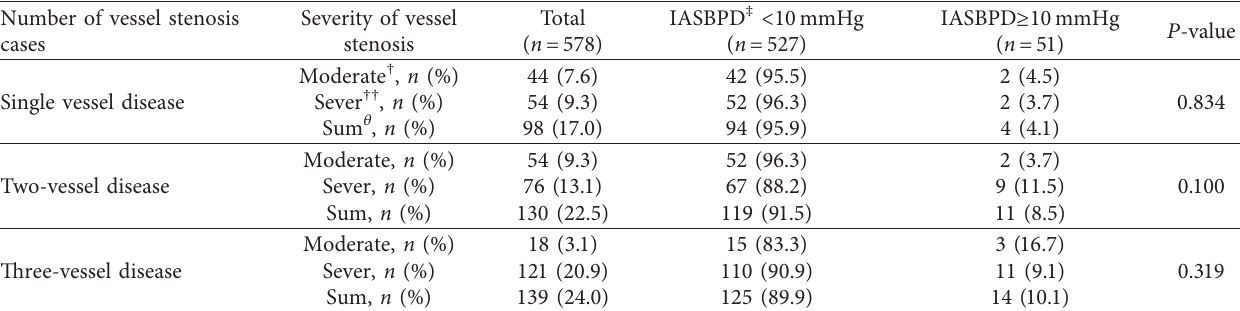
Two-vessel disease